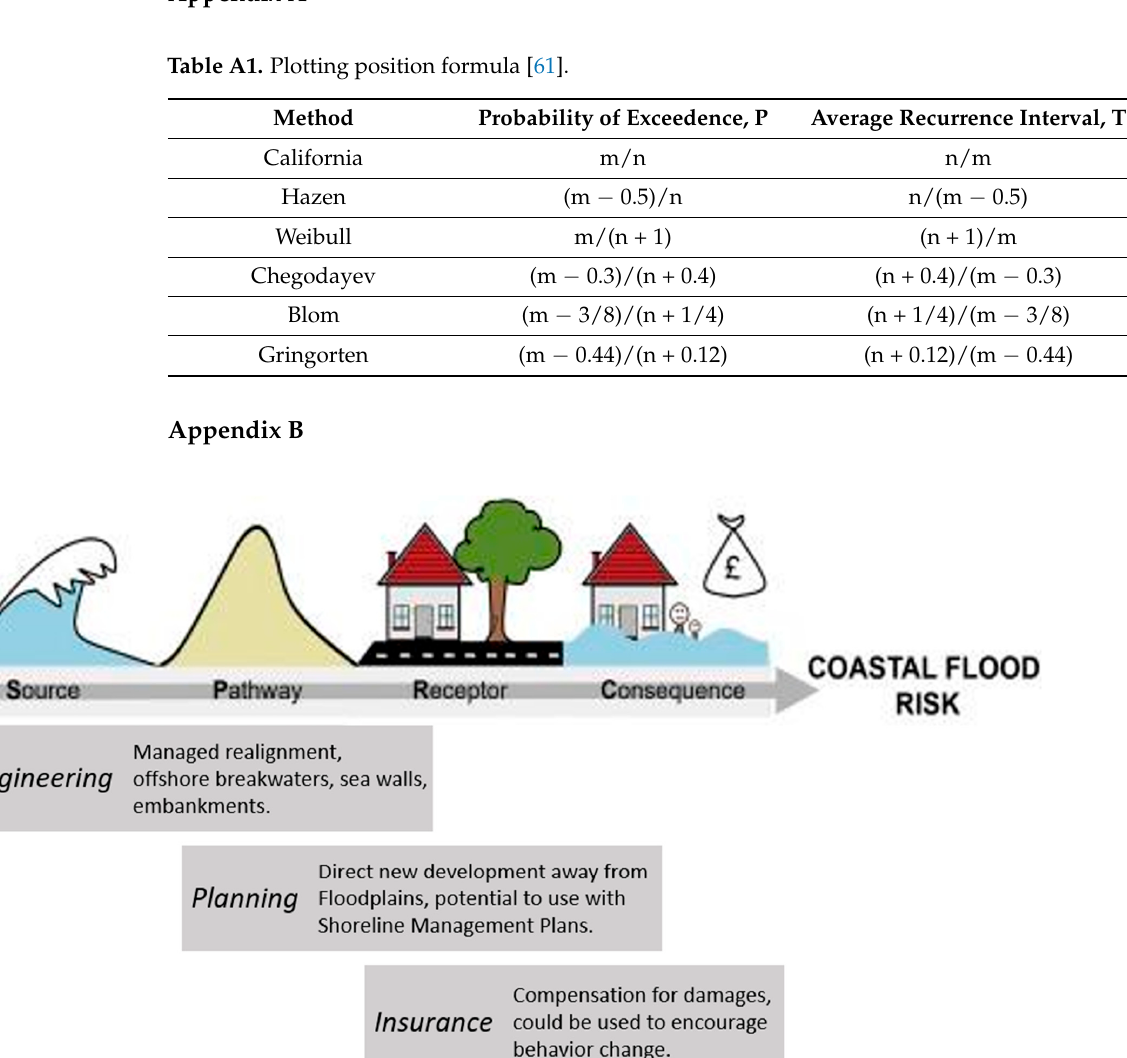
Table A2. Table of raw data and data sources.